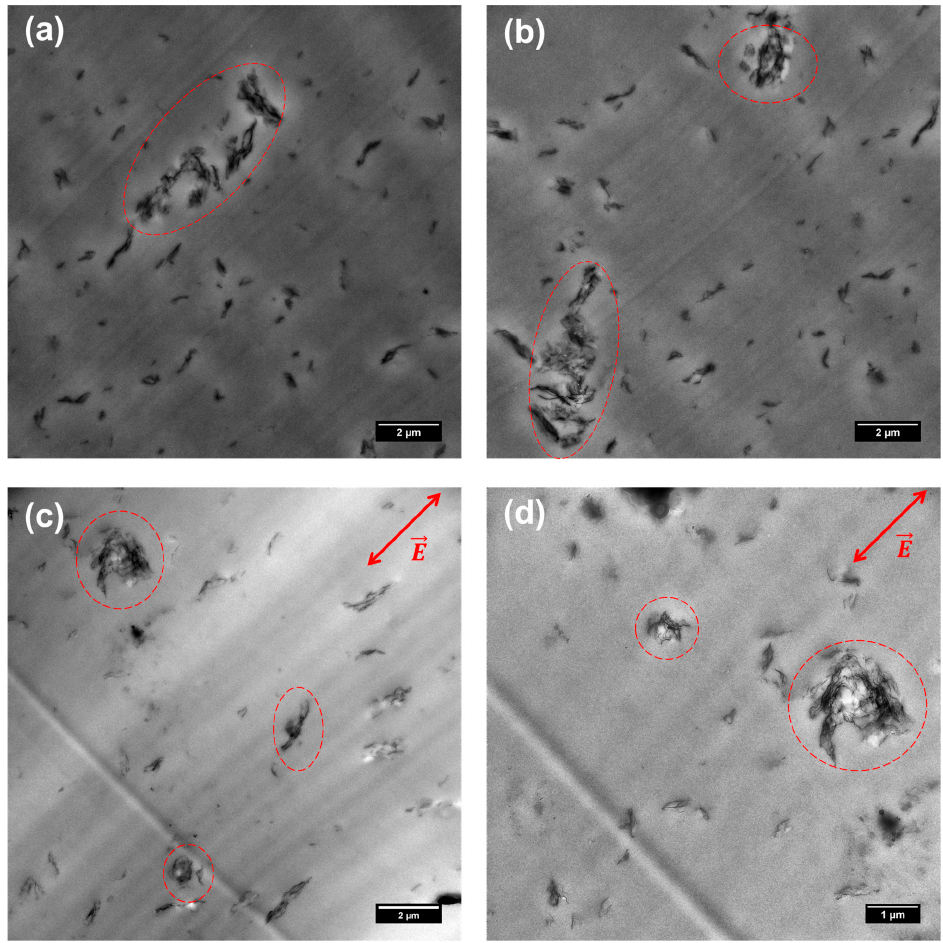
Figure 5. TEM images of EVA/GNP_0.25 wt% samples ( a , b ) before and ( c , d ) after 100 s electric field application ( E 0 = 400 V rms /mm and ω AC = 1 s − 1 ). ( c , d ) Direction of the alternating electric field determined by microtome artifacts. Locations of locally aggregated GNPs are highlighted by dashed